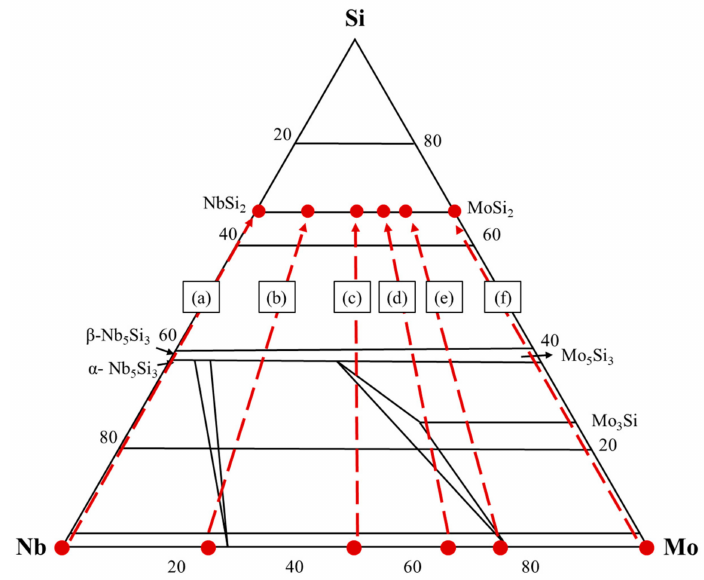
Figure 3. Schematic diagram of Nb–Mo–Si ternary phase diagram showing EDS measurements of substrates and coated layers. The points corresponding to the Nb–Mo–Si ratio of the Si-pack-coated Nb x Mo y alloys are shown in the Nb–Mo–Si systems with the compositions of ( a ) Alloy 1 (Nb), ( b ) Alloy 2 (Nb 73.6 Mo 26.4 ), ( c ) Alloy 3 (Nb 51.2 Mo 48.8 ), ( d ) Alloy 4 (Nb 35.1 Mo 64.9 ), ( e ) Alloy 5 (Nb 25.7 Mo 74.3 ), and ( f ) Alloy 6